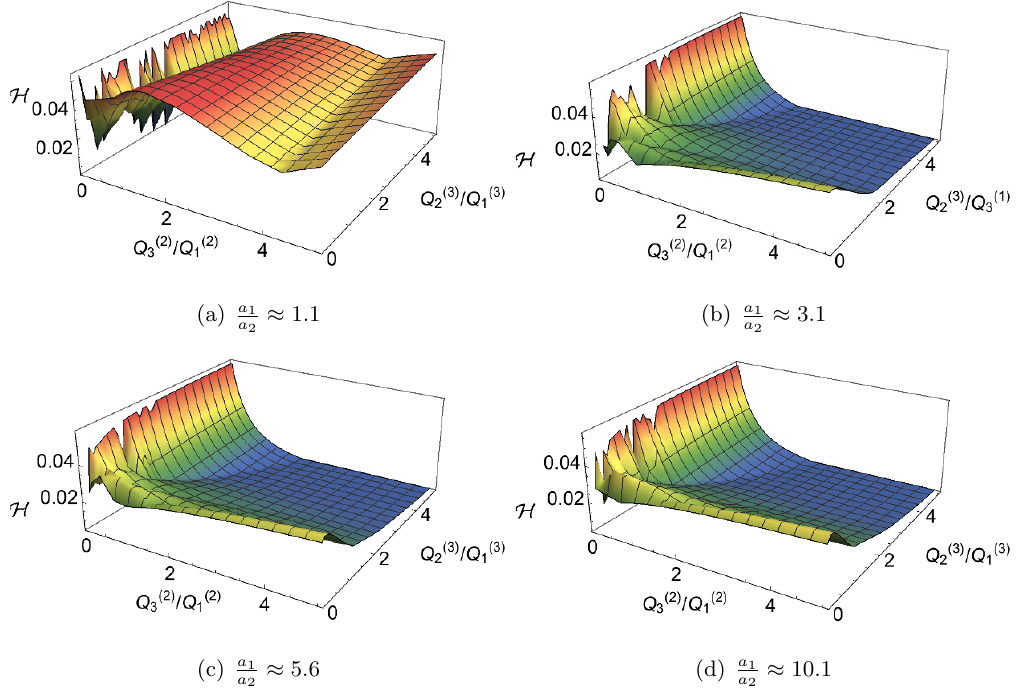
Figure 5 . The entropy parameter H as a function of two charge ratios and one distance ratio with q , k 1 , (cid:0) k 2 and k 3 equal to